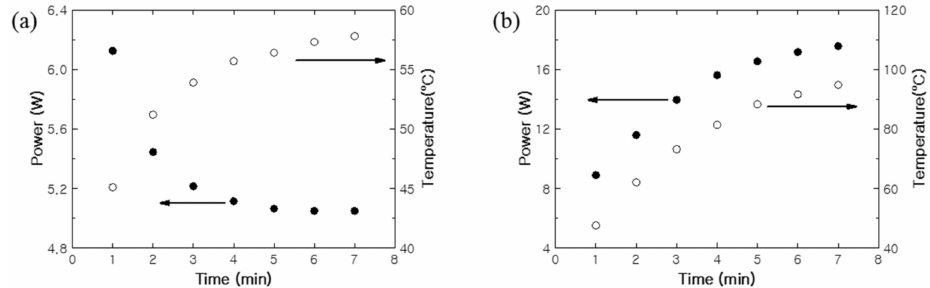
Figure 11. Power consumption and heating behavior of the ( a ) PTC-SHT and ( b ) negative temperature coefficient (NTC)-SHT under DC voltage of 5